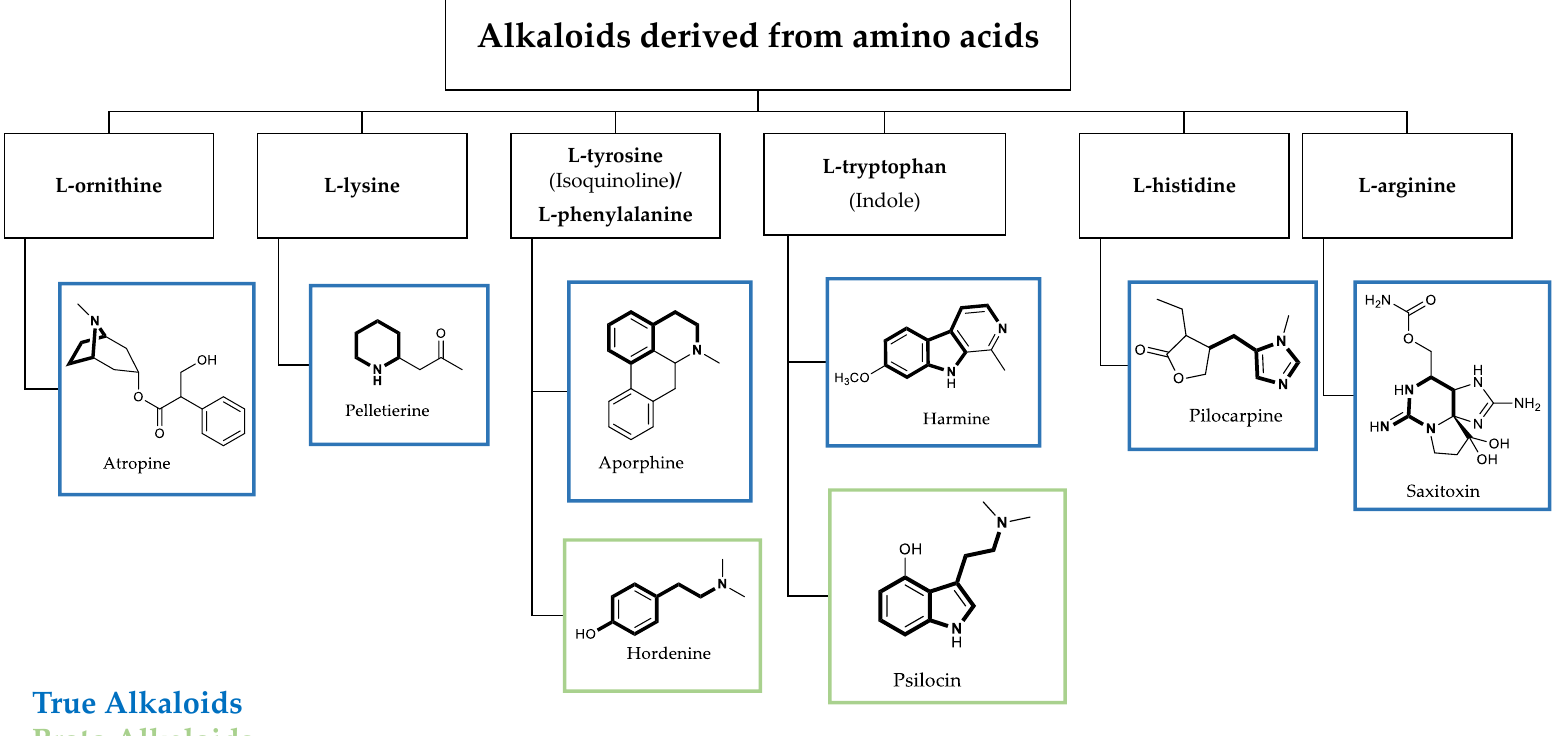
Figure 1. Schematic representation of true- and proto-alkaloids. The amino acidic skeleton derived from the natural precursor is in bold.